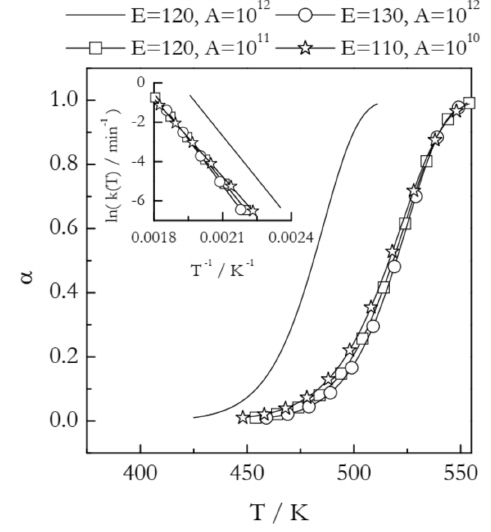
Figure 2. Kinetic curves simulated at the heating rate 2 K min − 1 for a first order reaction having different values of the activation energy ( E in kJ mol − 1 ) and preexponential factor ( A in min − 1 ). The inset shows respective Arrhenius